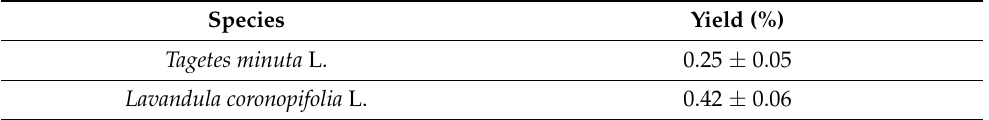
Table 2. Yields of essential